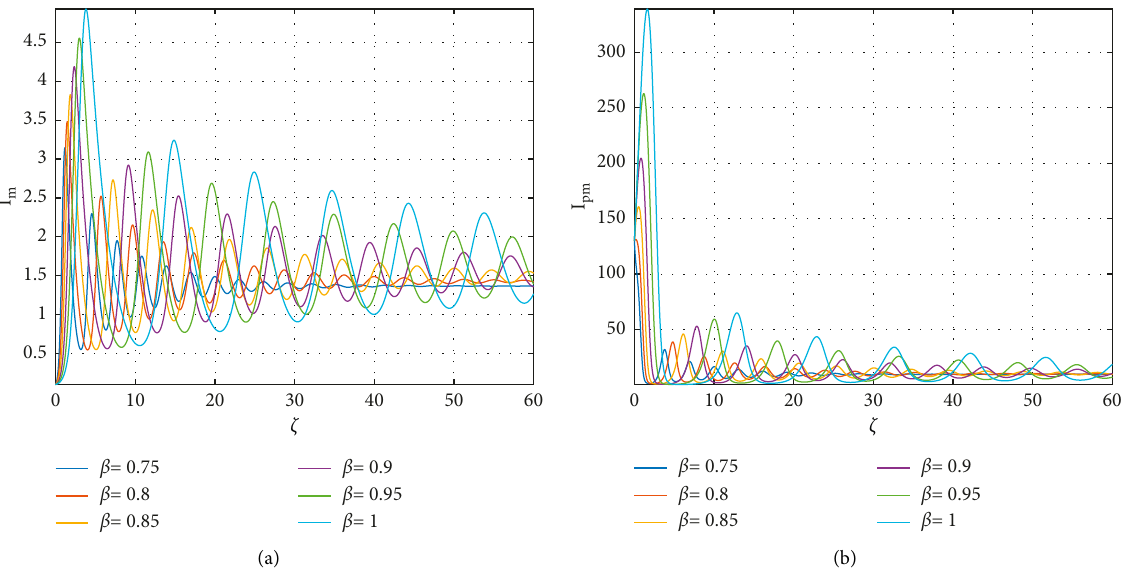
Figure 13: Two-dimensional illustration of the meningitis infection I co-infection ρ for multiple fractional orders β ∈ [ 0 , 1 ]